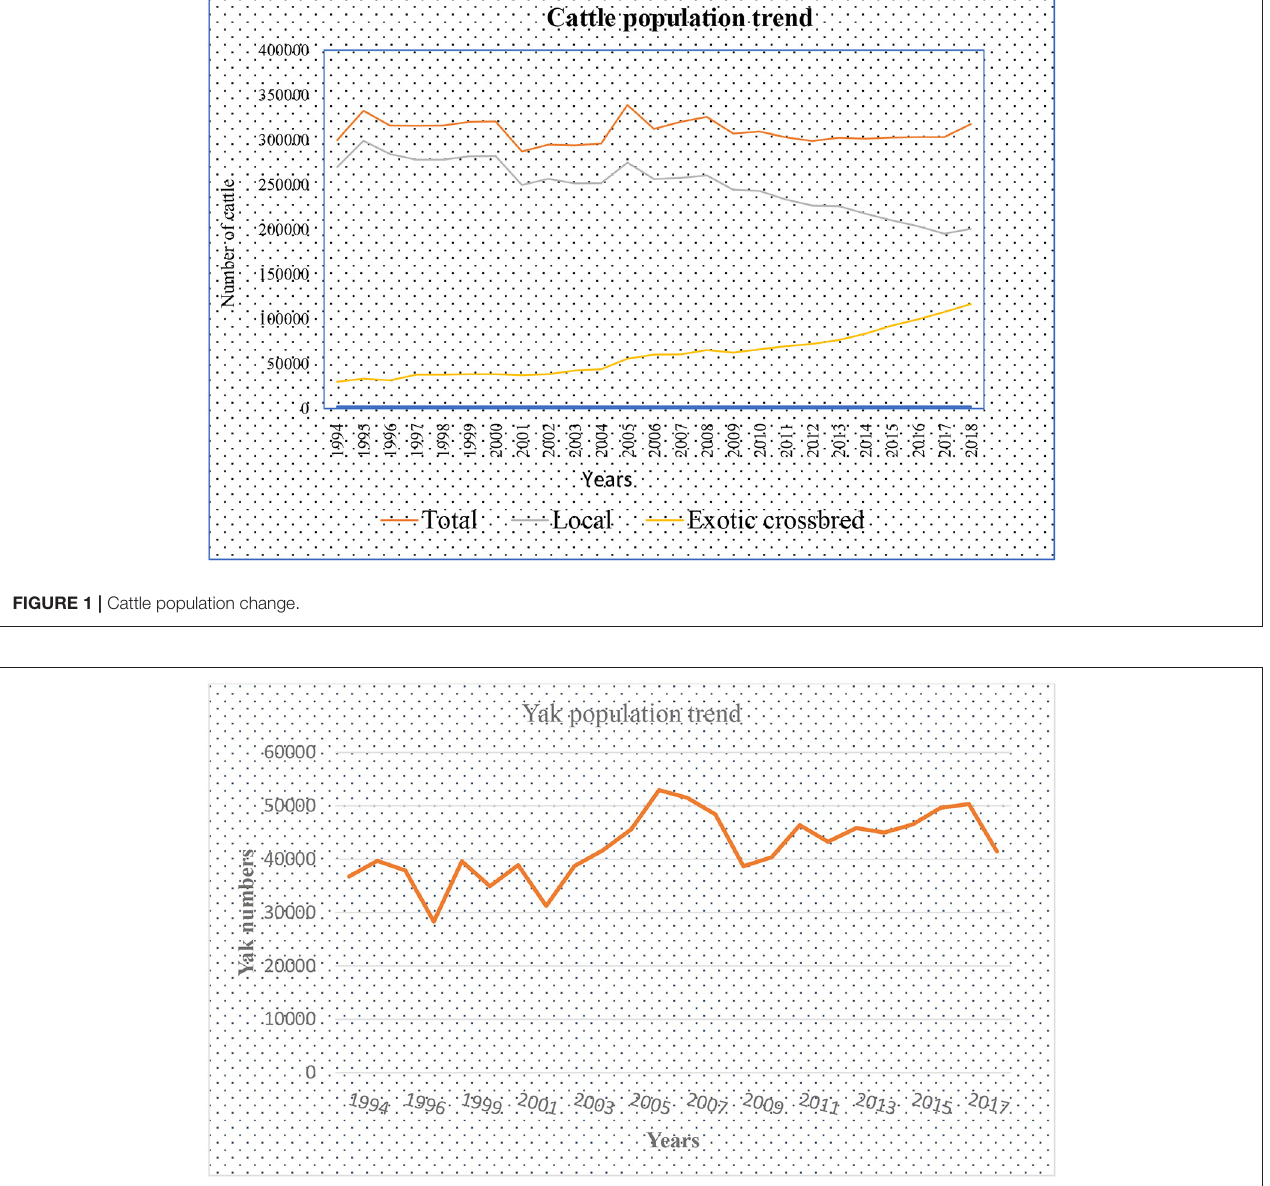
FIGURE 2 | Yak population